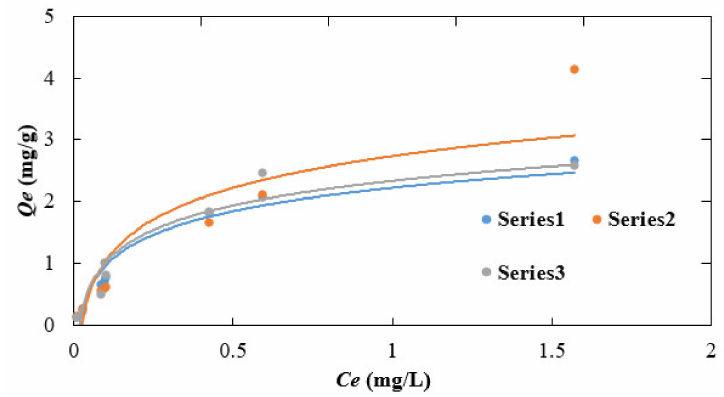
Figure 11. Adsorption isotherms of Cr(VI) using the SDS-chitosan beads.